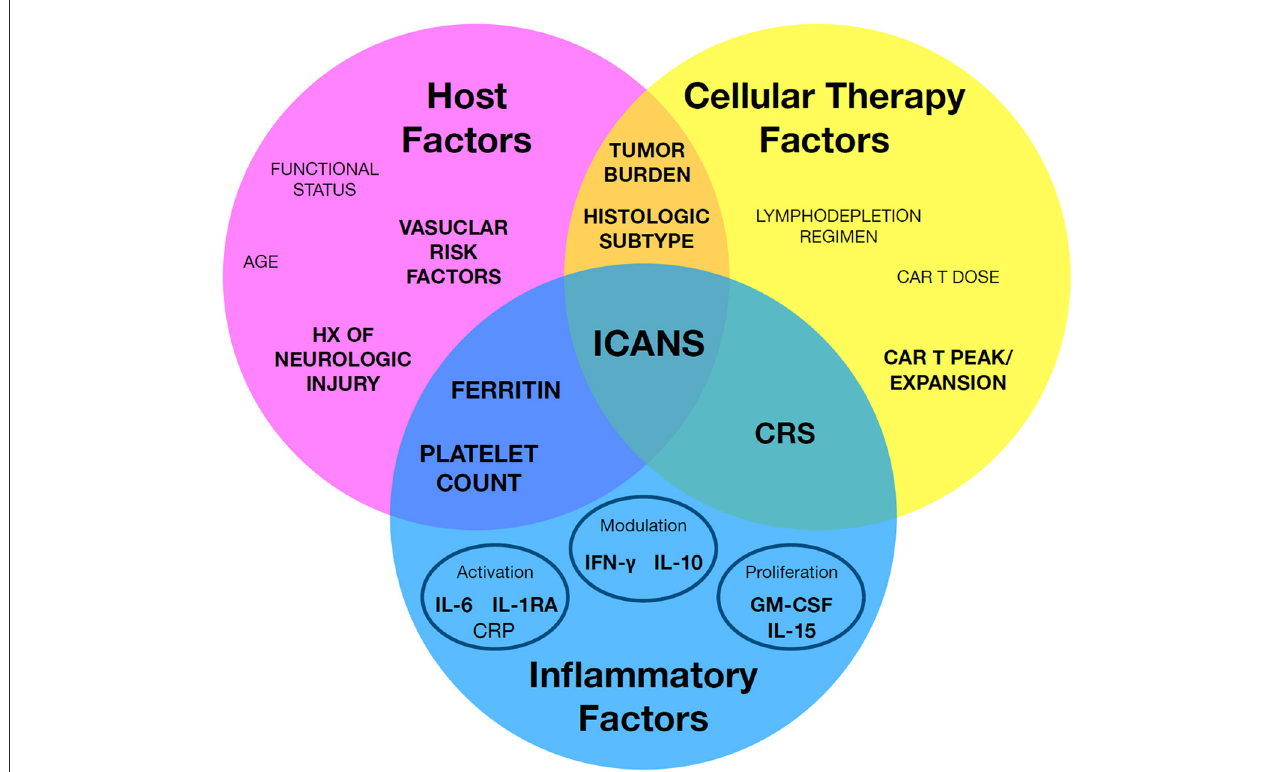
FIGURE1 A framework to organize known immune effector cell-associated neurotoxicity syndrome (ICANS) risk factors. Individual factors may be broadly grouped by host factors, cellular therapy factors, and inflammatory factors. Notably, a subset of key factors bridge between classes, such as cytokine release syndrome (CRS). Factors with the strongest associated evidence are in highlighted in